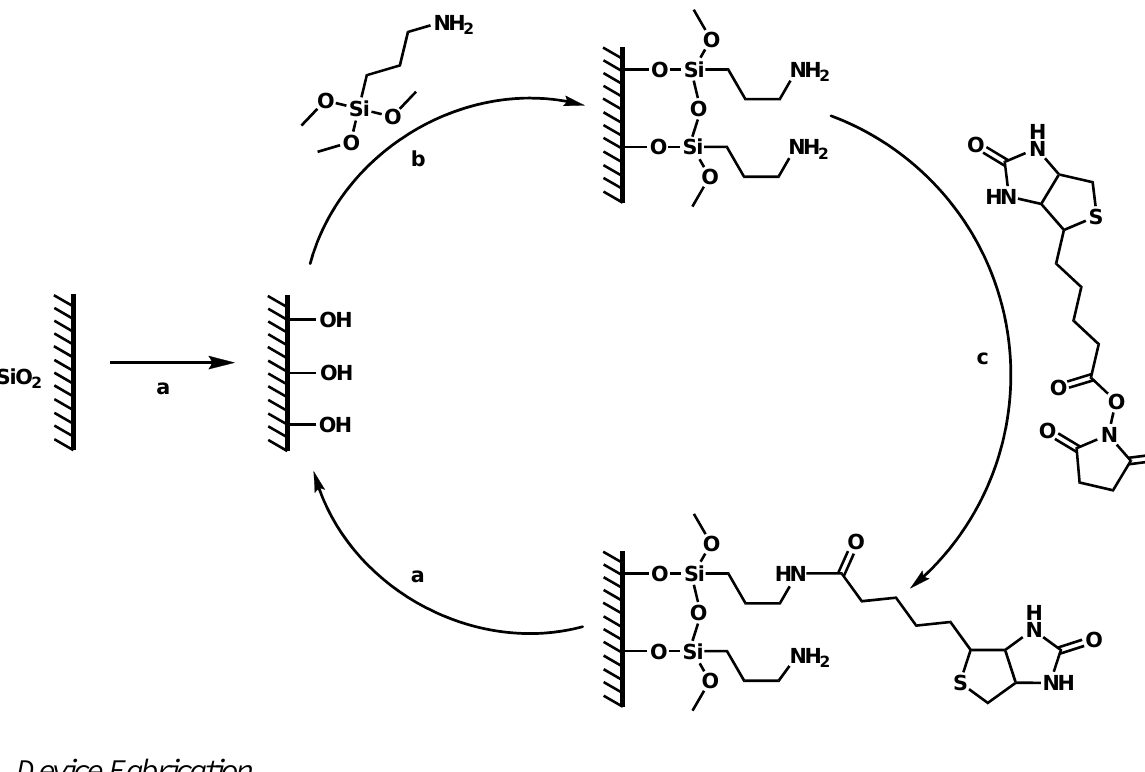
Figure 2. Overall reaction scheme for the biotinylation of silica